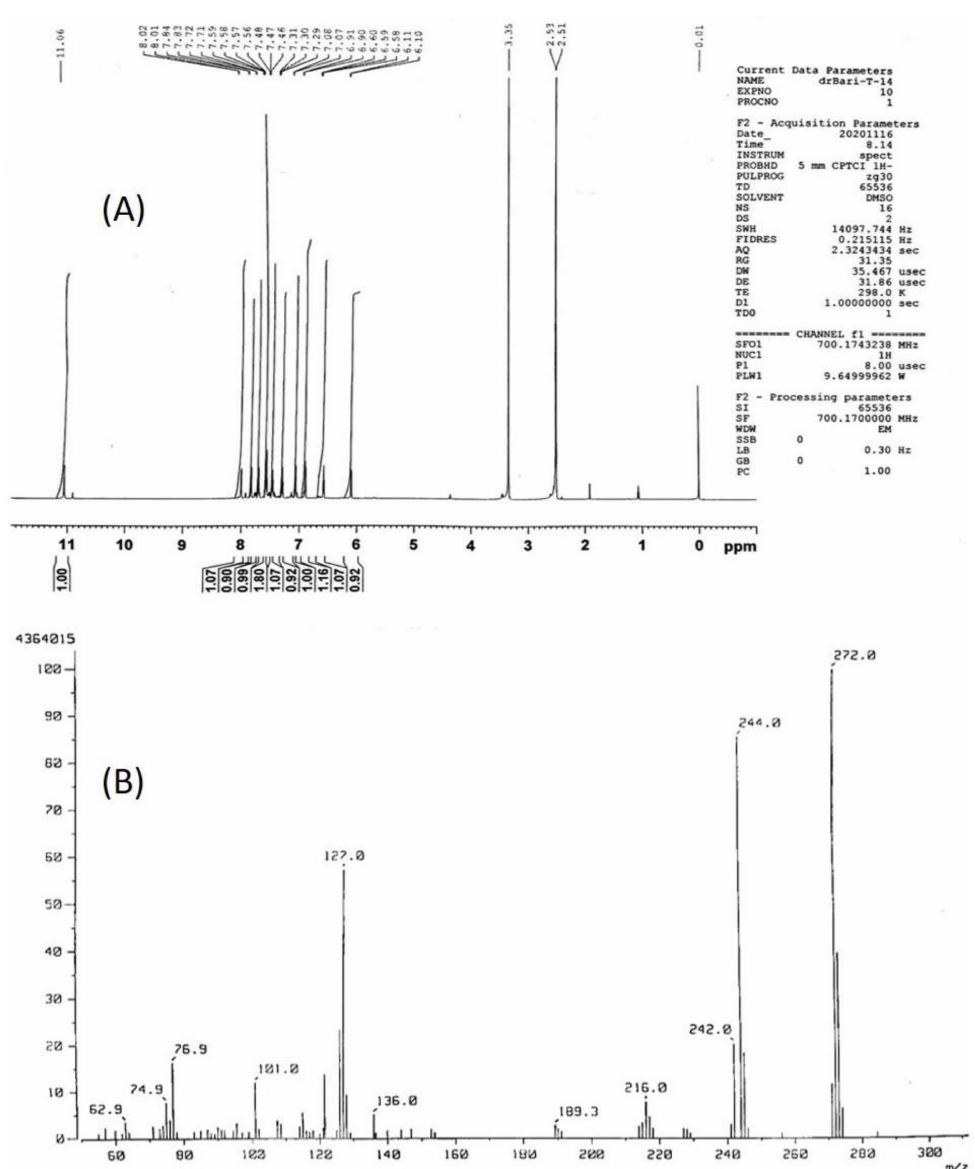
Figure 2. 1 H-NMR spectra (500 MHz) ( A ) and mass spectra ( B ) of